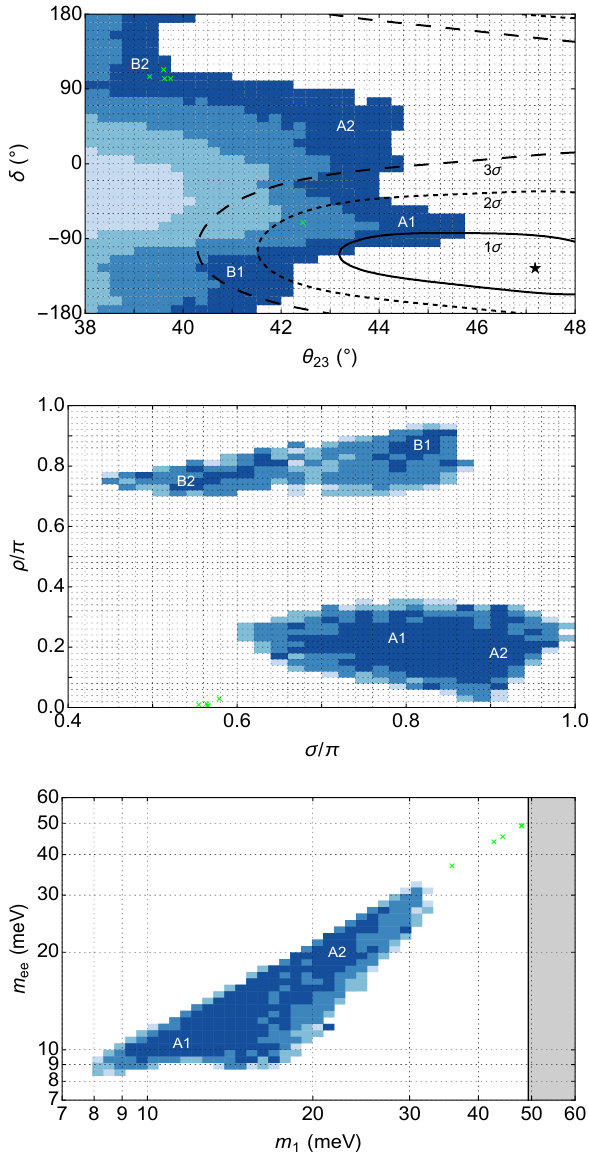
Figure 1 . STSO10 leptogenesis allowed region projected on three di(cid:11)erent low energy neutrino parameters planes for the benchmark case (cid:11) 2 = 5 and N p ; i = 10 (cid:0) 3 . The regions with di(cid:11)erent blue B (cid:0) L graduation indicate the regions containing 68%, 95%, 99 : 7% and 100% of the solutions (respectively from lightest to darkest blue) in the plane (cid:14) versus (cid:18) 23 . The green crosses correspond to special muon-dominated solutions. In the top panel, the black lines represent the results of the latest global neutrino analysis [8] with the best (cid:12)t indicated by the star. The gray band in m 1 is the excluded region from the cosmological upper bound on m 1 from Planck